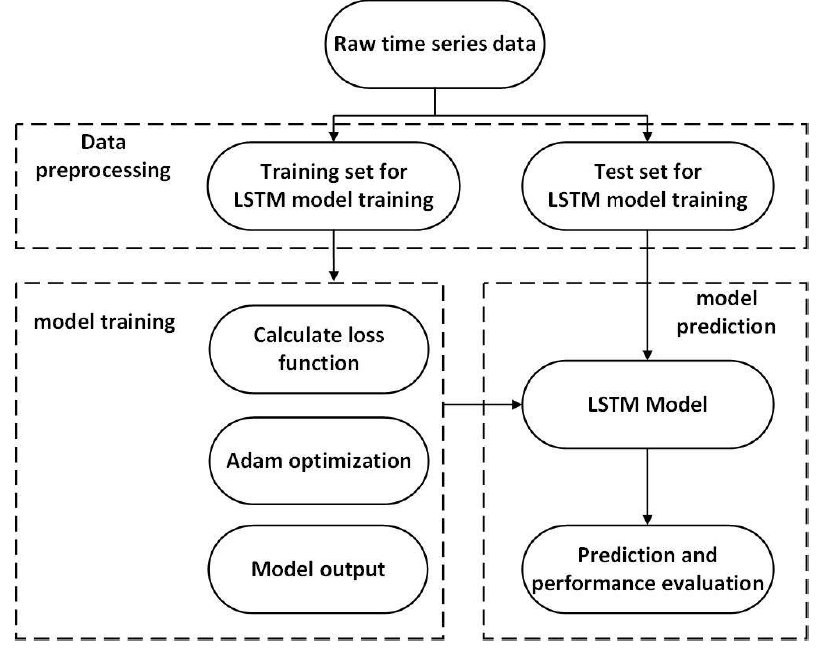
Figure 2. LSTM method diagram.